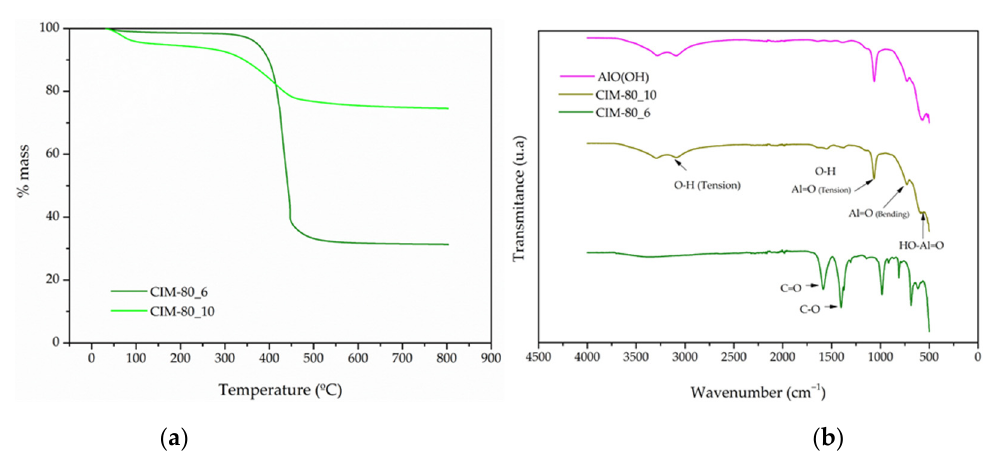
Figure 8. ( a ) Thermogravimetric analysis (TGA) curves in a nitrogen atmosphere of CIM-80_6 and CIM-80_10 samples; ( b ) FTIR spectra for the CIM-80_6, CIM-80_10 and AlO(OH) samples. For the CIM-80_10 and AlO(OH) samples, the same bands are present throughout the spectrum. The band corresponding to the bending vibration of the O-H group appears